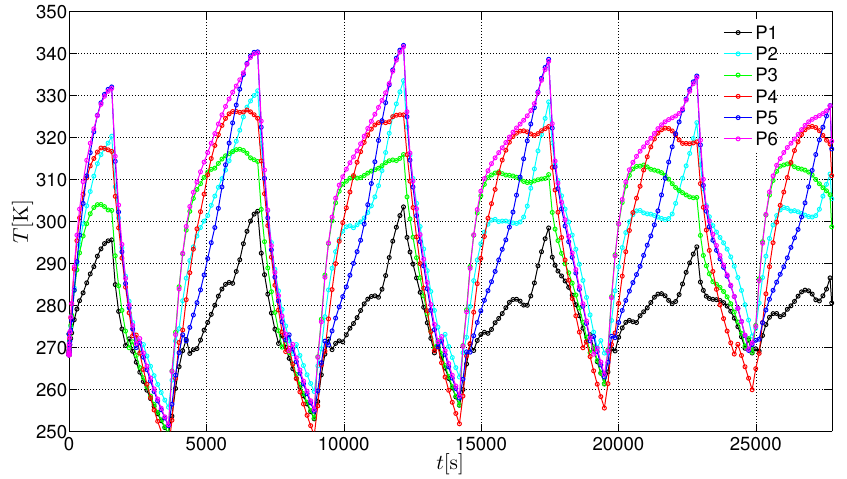
Figure 6. Average temperature in each composite panel as function of time ( β = 57 ◦ ).